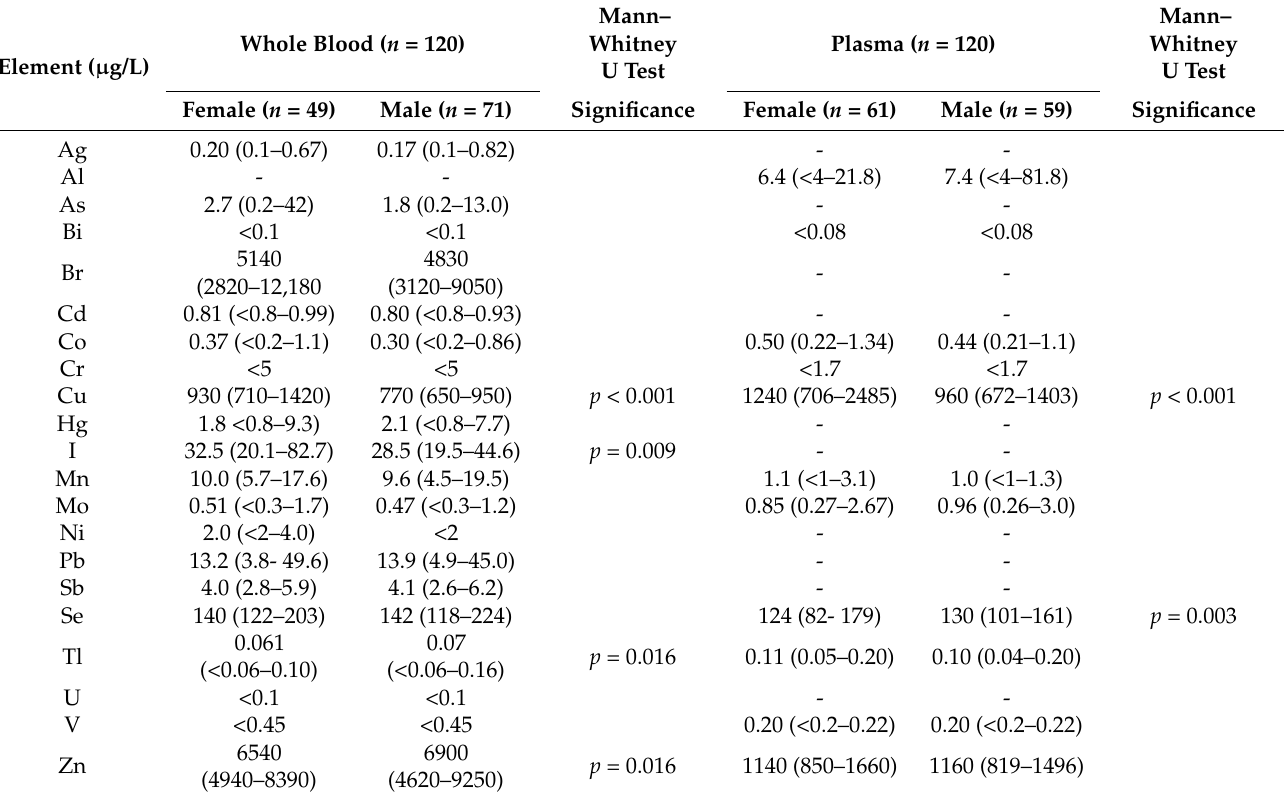
Table 6. Trace element levels (mean and range) in whole blood and plasma of males and